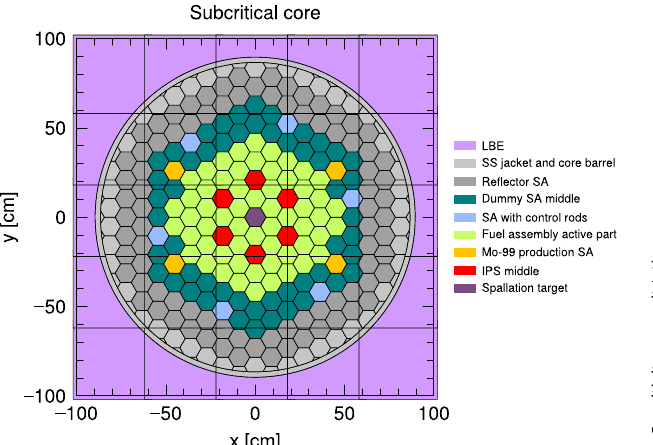
Fig. 2. Horizontal sectional view of MYRRHA subcritical core.